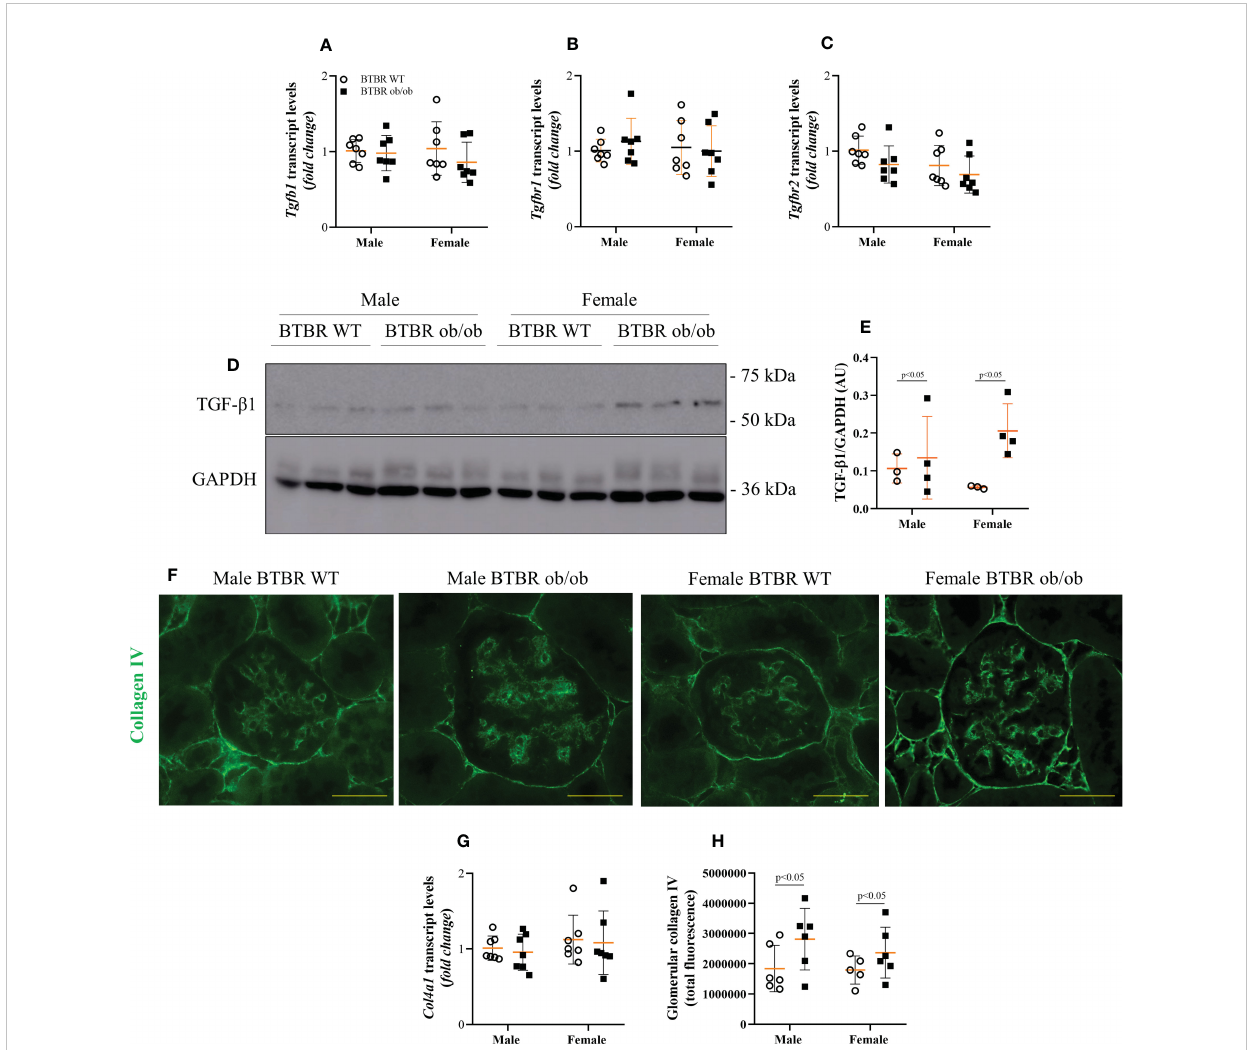
FIGURE 3 Obesity and diabetes increase whole kidney TGF- b 1 content and glomerular expression of collagen IV in both males and females. Effects of sex and metabolic condition in BTBR mice on Tgfb1 (A) , Tgfbr1 (B) , and Tgfbr2 (C) transcript levels, TGF- b 1 protein expression (D, E) , collagen IV transcript levels (G) , and glomerular collagen IV content (F, H) . The values are the mean±SD (n=3 - 7). Immuno fl uorescence images were captured using NIS-Elements software coupled to a light microscope equipped with a 40x objective at laser excitation of 488 nm (Eclipse 80i). Bars = 50 m m. WT, wild type; AU, arbitrary units; Tgfb1 , TGF- b 1; Tgfbr1 , TGF- b receptor 1; Tgfbr2 , TGF- b receptor 2; Col4a1 , collagen IV. p values corresponding to the independent effect of metabolic condition or sex are speci fi ed in the